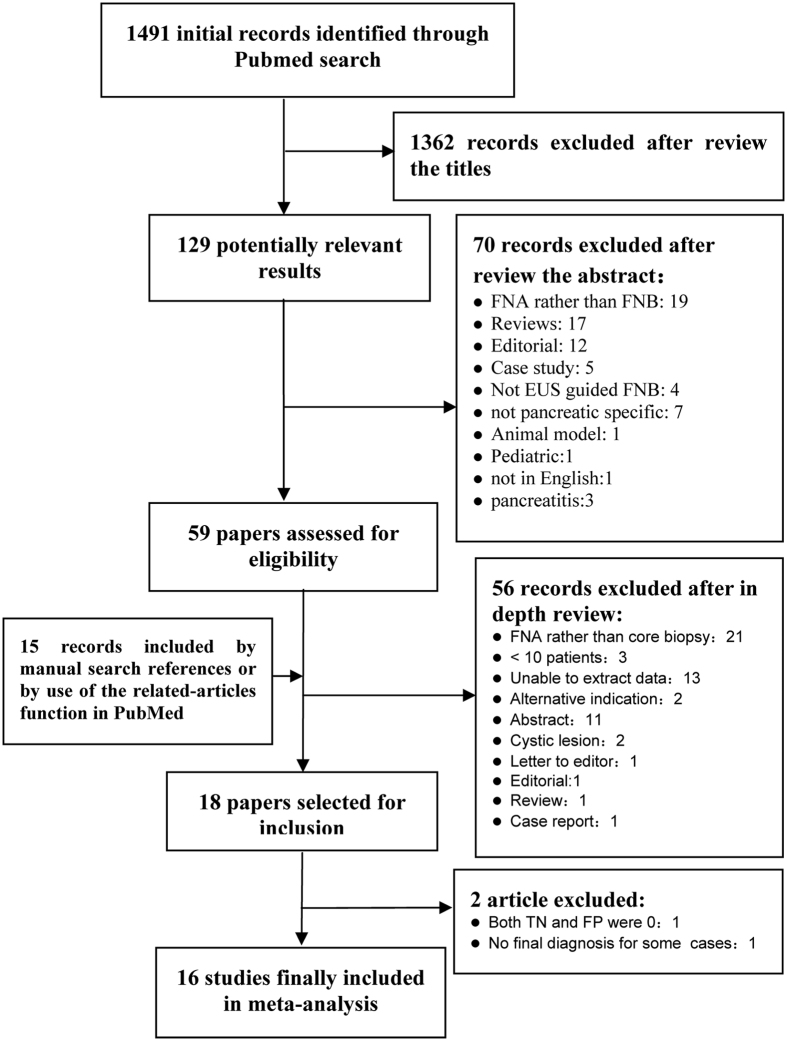
Flow chart of the study selection process for eligible studies in the systematic review.EUS, endoscopic ultrasound; FNA, fine needle aspiration; FNB, fine needle biopsy.